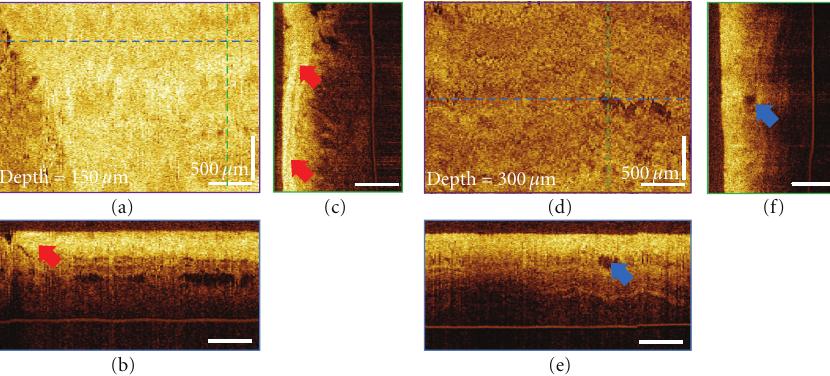
Figure 3: Magnified orthoplanes of the treated area showing the hyperscattering feature of the burned tissue as the red arrows indicated and the hyposcattering feature of the residual BE glands as the blue arrows indicated.